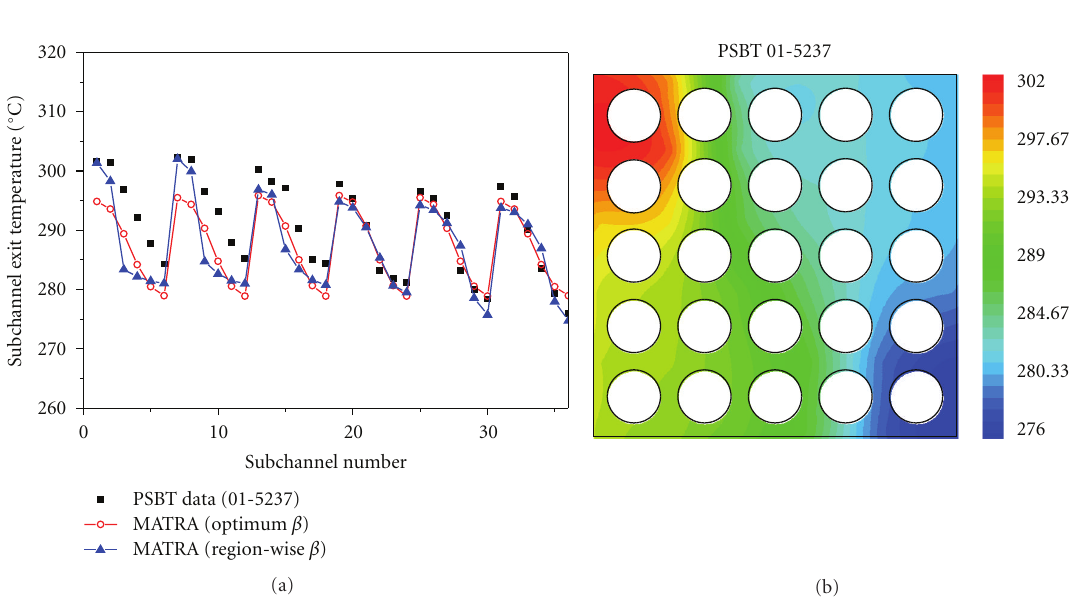
Figure 8: E ff ects of regionwise turbulent mixing parameters in the MATRA